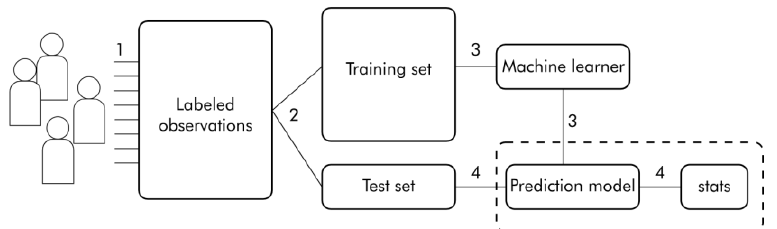
Figure 17. Supervised learning. Steps: (1) made annotations in the dataset; (2) dataset separation; (3) algorithm training; (4) dataset test for algorithm evaluation and performance (Adapted from [25]).